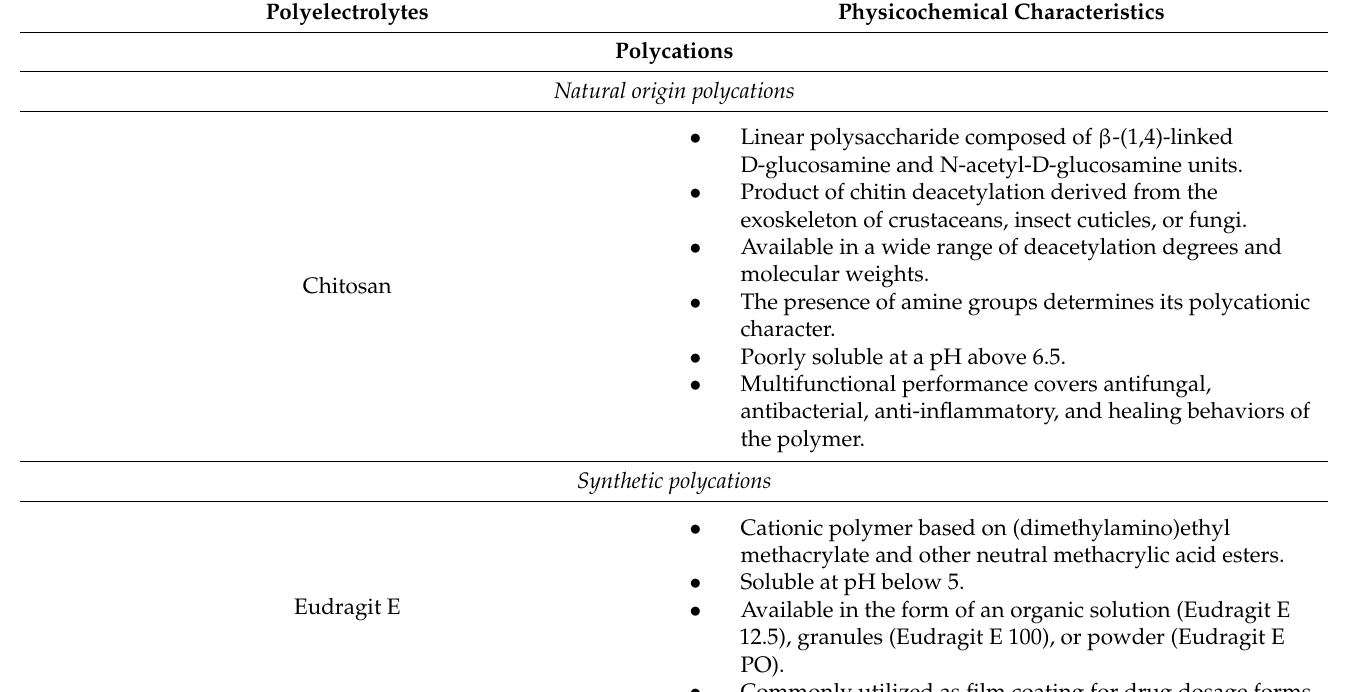
Table 1. Physicochemical characteristics of the selected polyelectrolytes used in PEM preparation [3,25–28].